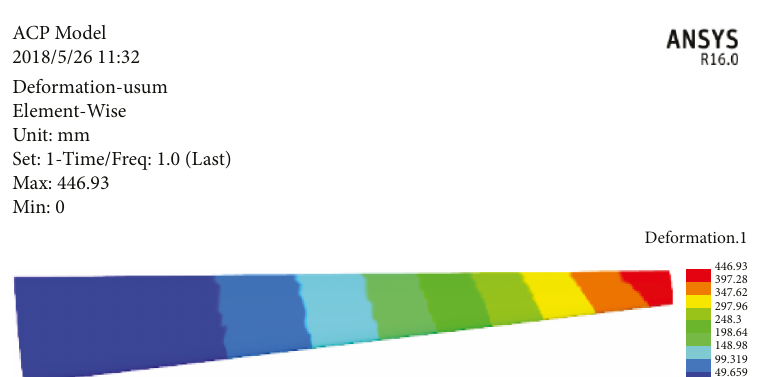
Figure 20: Deformation cloud diagram with the layer sequence being [90/45/0/-45/90]